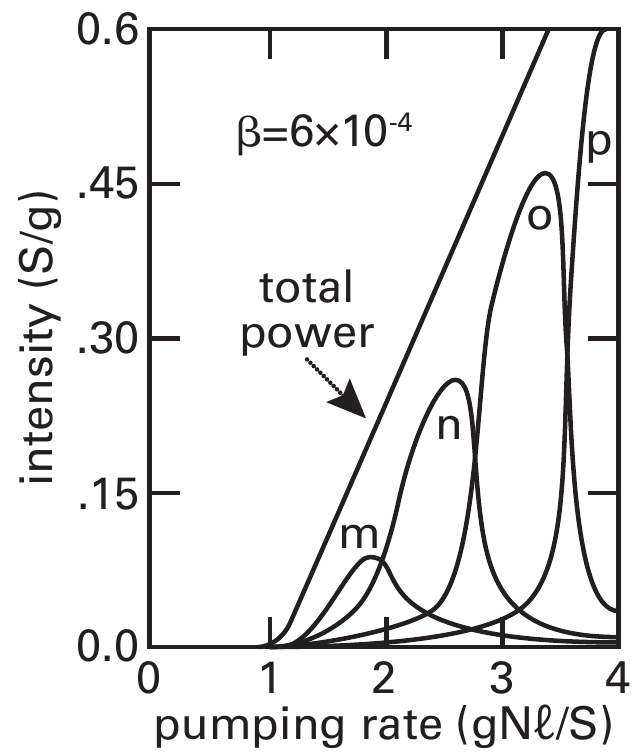
Figure 4. Matching simulation for Figure 3. Adapted from Figure 4 of